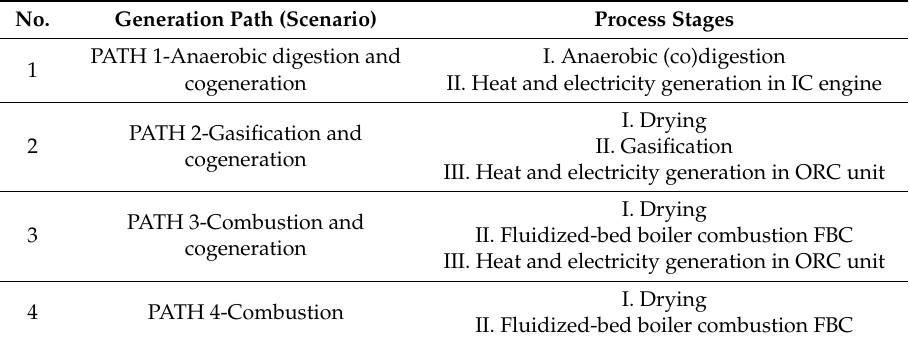
Table 4. Analyzed chicken manure energy generation routs